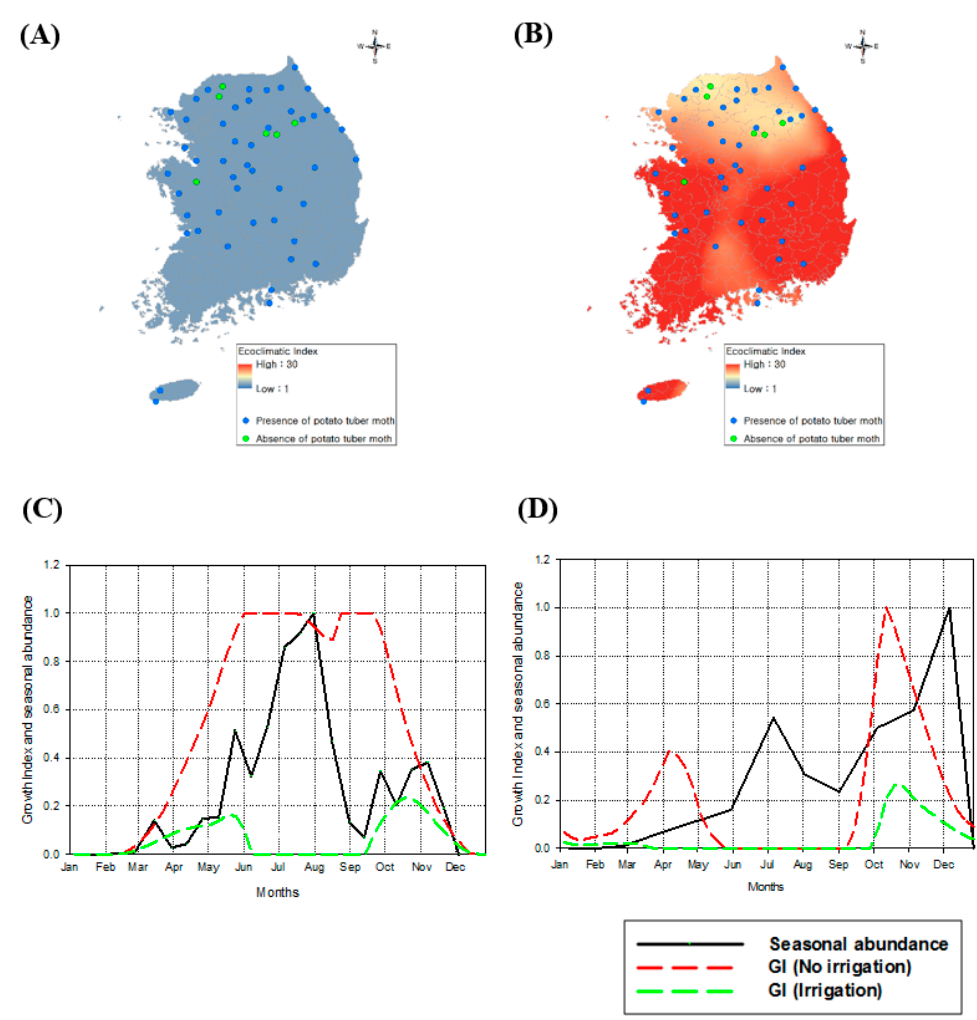
Figure 2. Potential distribution of potato tuber moth in South Korea, ( A ): With irrigation scenario, as per Jung et al. (2020), ( B ): Without irrigation, and comparison of growth indices of potato tuber moths with seasonal abundance from field surveys in ( C ) Miryang and ( D ) Seogwipo.